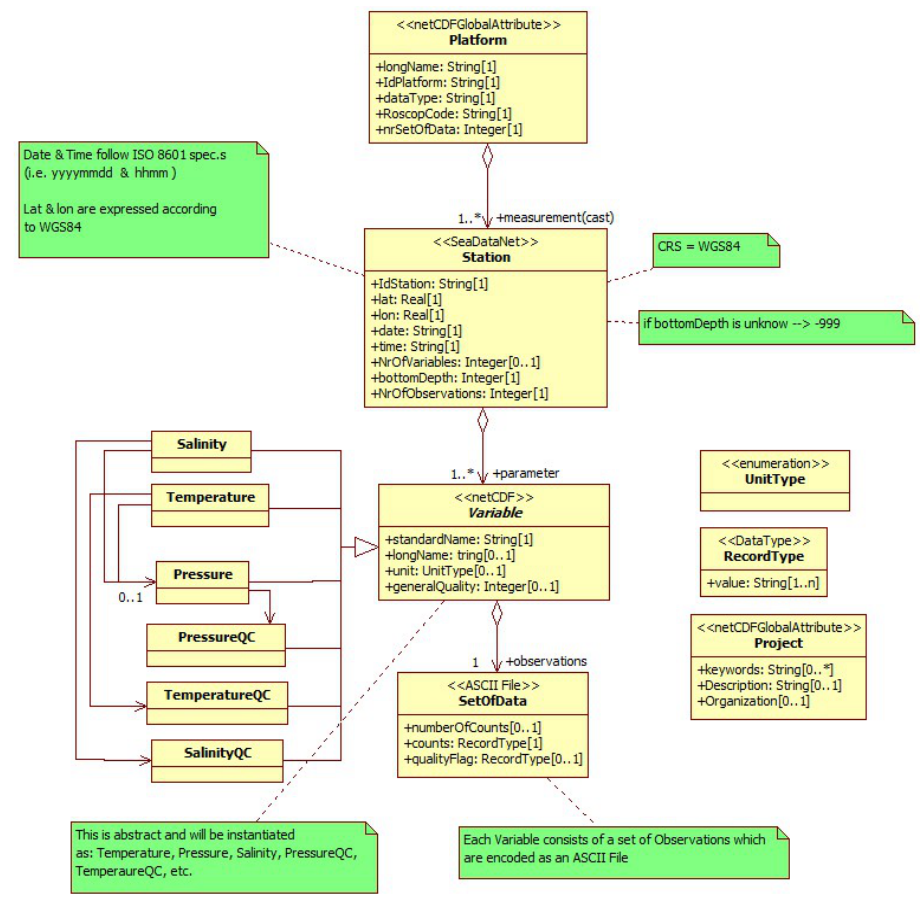
Fig. 8. CF-netCDF Data Model for XBT Figure 8: CF-netCDF Data Model for XBT datasets 2